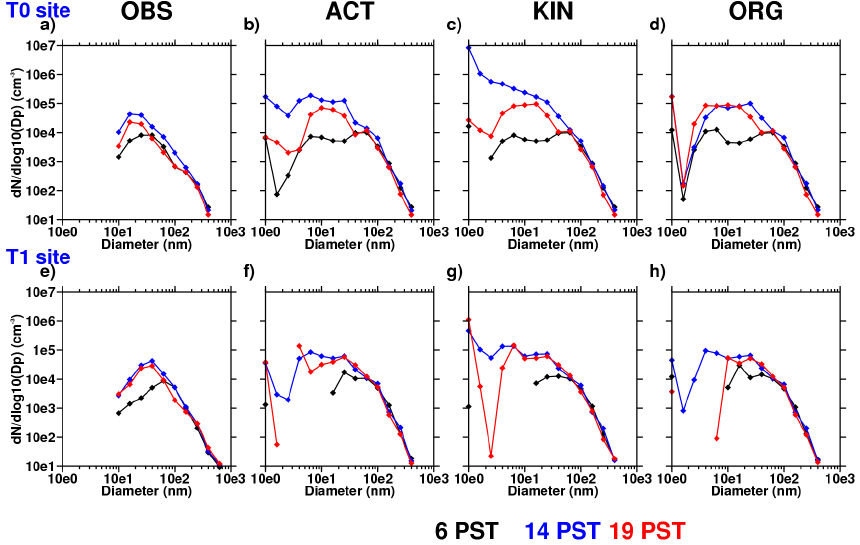
Figure 12. Particle number distribution for observations (OBS) and the ACT, KIN, and ORG simulations at the T0 (a–d) and T1 (e–h) sites at 10:00PST (black line), 14:00PST (blue line) and 19:00PST (red line) on 8 June 2010. The missing line segments in the simulations correspond to particle numbers lower than 10cm − 3